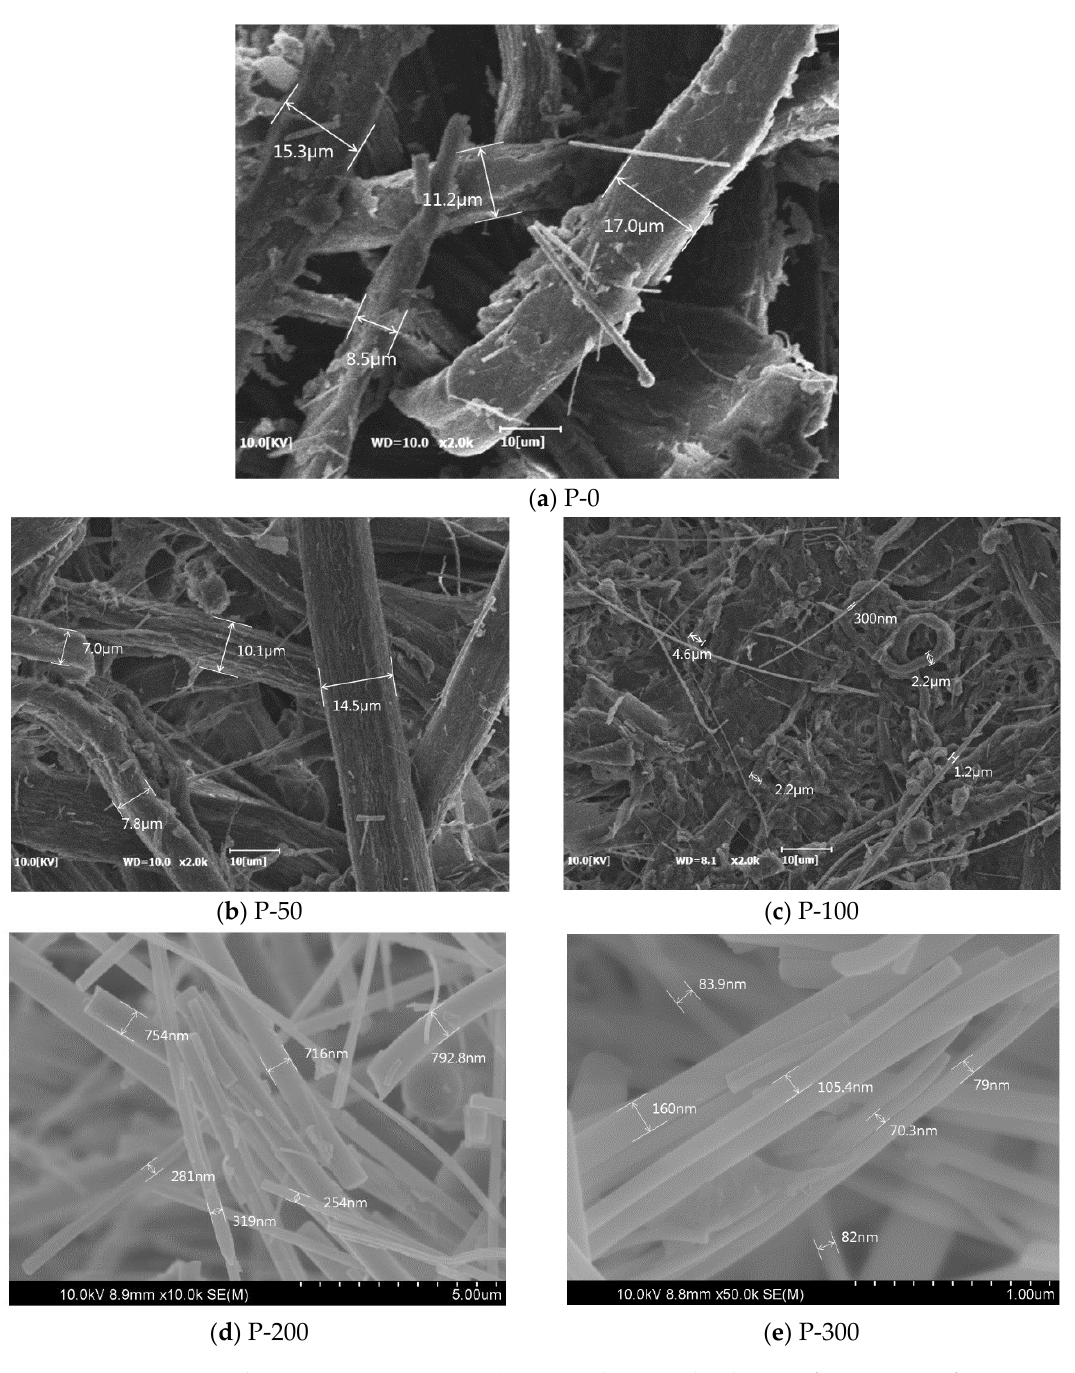
Figure 3. Scanning electron microscopy (SEM) images showing the degree of separation of ( a ) P-0, ( b ) P-50, ( c ) P-100, ( d ) P-200, and ( e ) P-300.